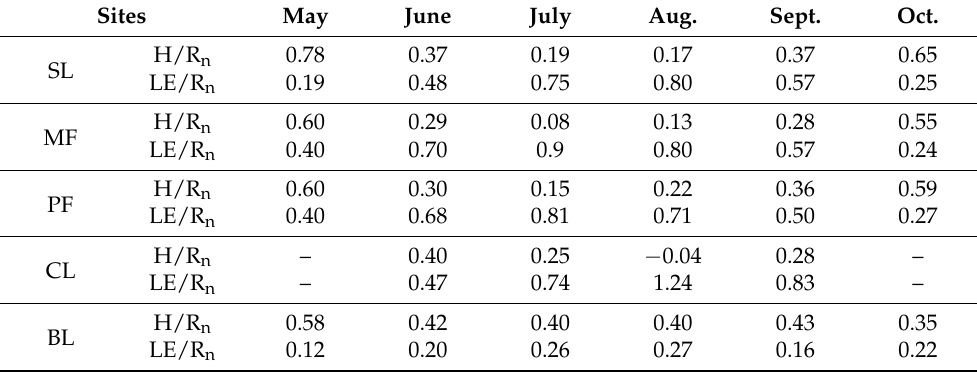
Table 4. Ratios of monthly H and LE to R n (8:30–18:30 BST; Beijing Standard Time) at the five sites during the growing season of May–October in